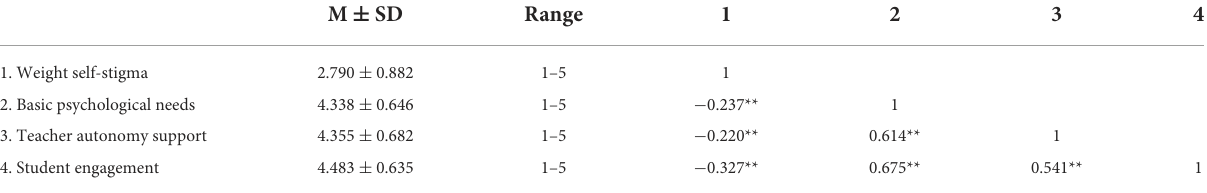
TABLE 3 Mean, standard deviation, and correlation coefficient of each